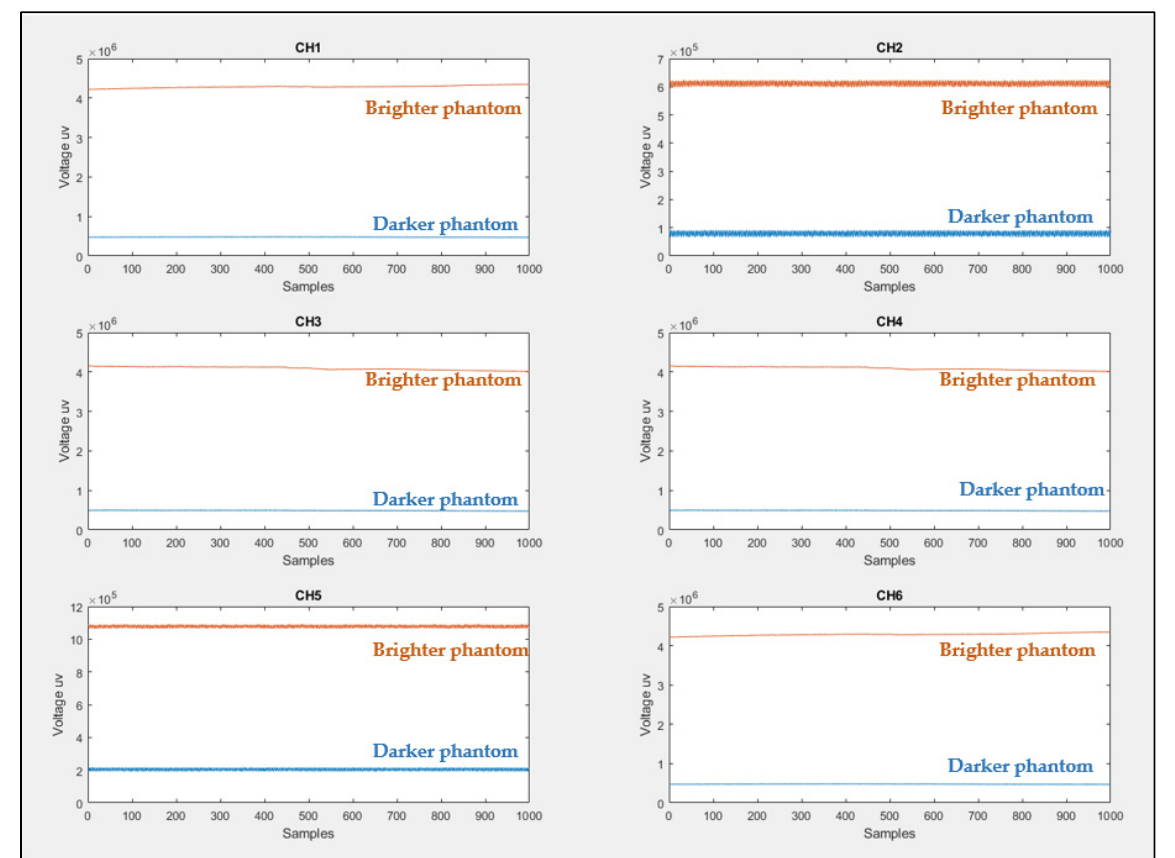
Figure 16. Darker and brighter silicone rubber phantoms.